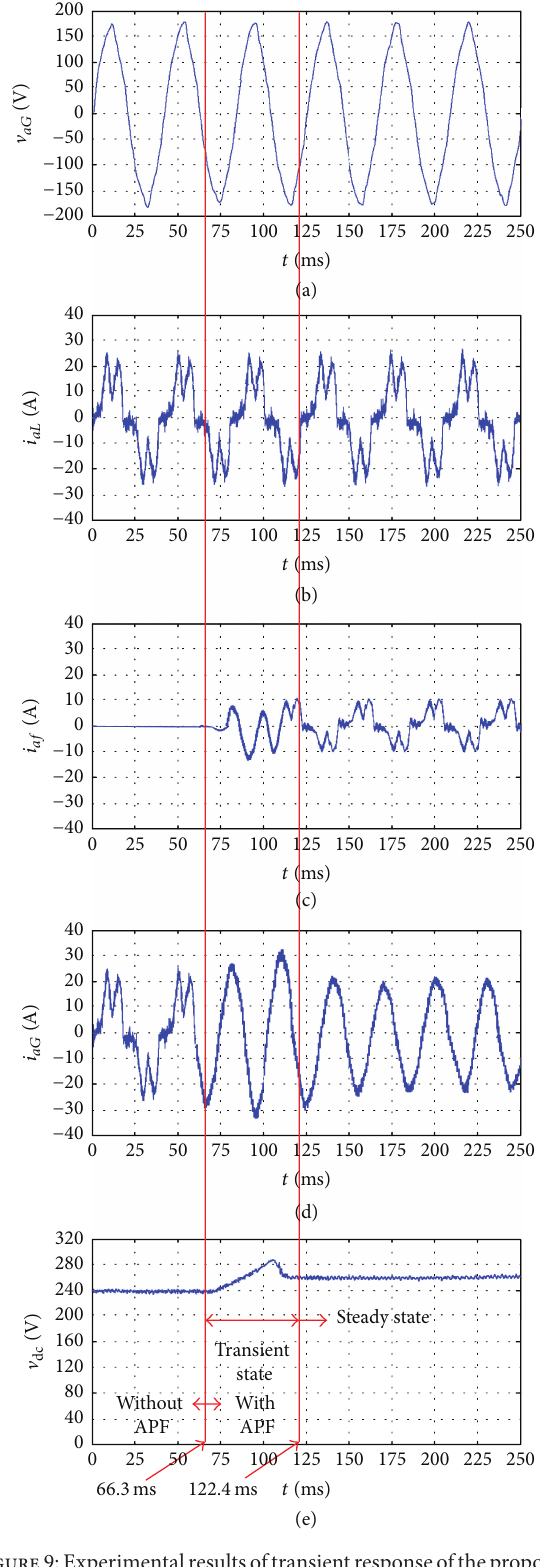
Figure9:Experimentalresultsoftransientresponseoftheproposed system with balanced nonlinear load: (a) phase voltage V 𝑎𝐺 of the wind generator; (b) nonlinear load current 𝑖 𝑎𝐿 ; (c) active power filter current 𝑖 𝑎𝑓 ; (d) line current 𝑖 𝑎𝐺 of the wind generator; (e) DC-link voltage V dc